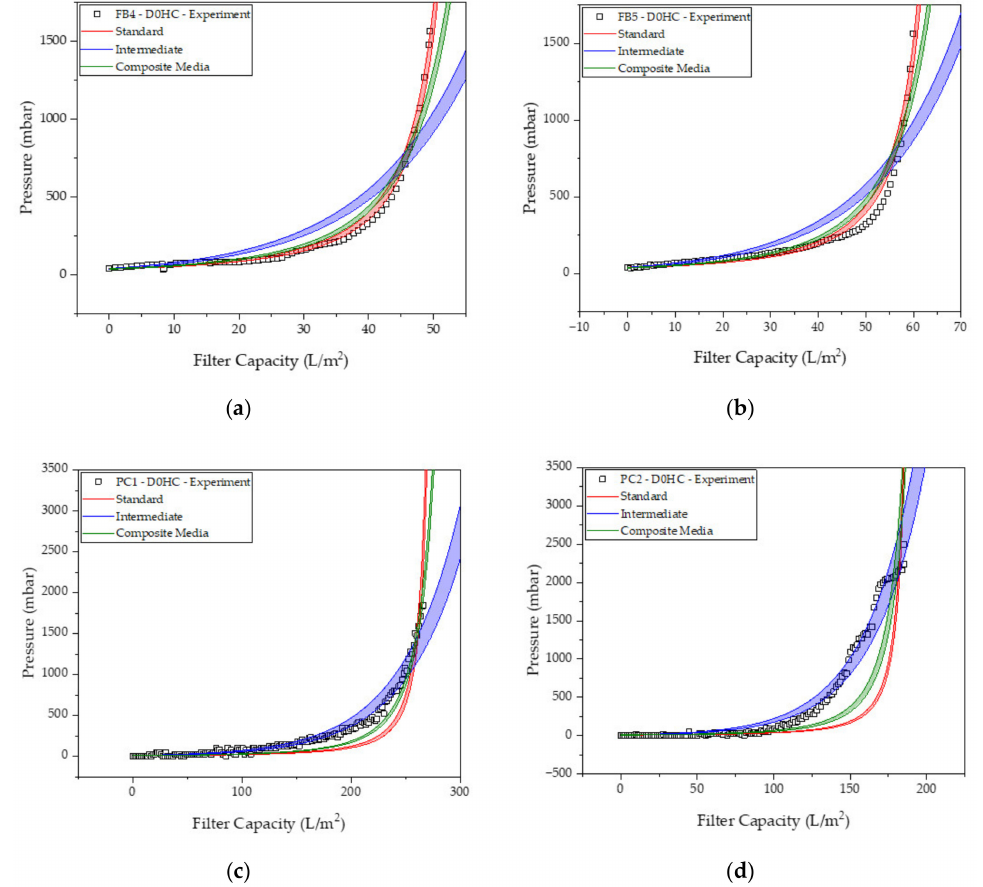
Figure 6. Increase in pressure over filter capacity during constant flux direct (not pre-clarified) depth filtration of FB4 ( a ) and FB5 ( b ) as well as of pre-clarified feed PC1 ( c ) and PC2 ( d ). Experimental pressure values (black squares) are compared with the modeling of standard blocking (red lines), intermediate blocking (blue lines), and composite media models (green lines). The dashed lines indicate the maximum/minimum deviation resulting from Monte Carlo simulation